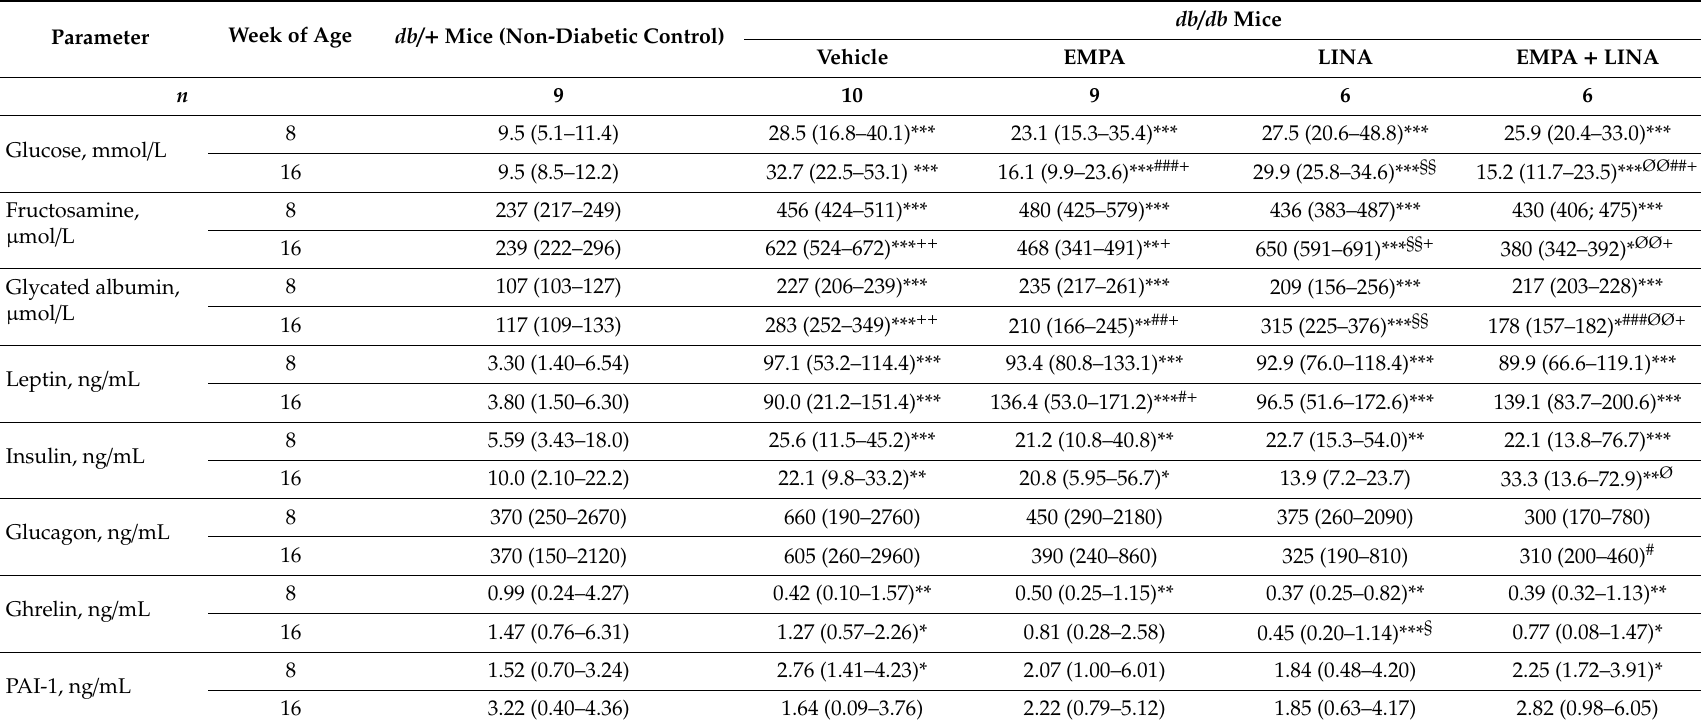
Table 2. Plasma biochemical parameters and hormones in db / db and db /+